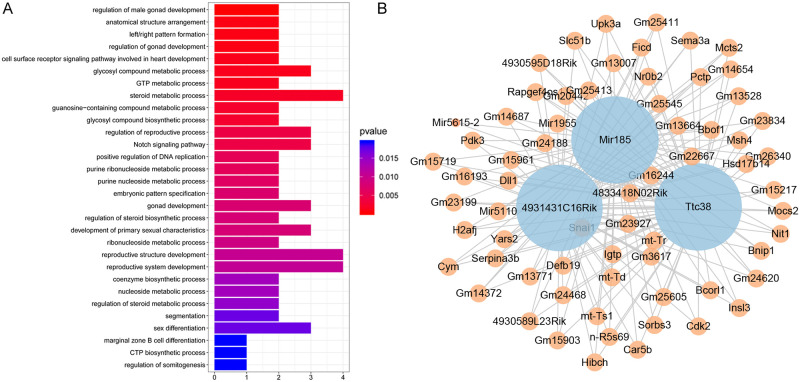
Functional enrichment analysis and the protein-protein interaction (PPI) network of eigengenes in the brown4 module.(A) The GO biological processes that involve the eigengenes in the brown4 module. (B) The PPI network of eigengenes in the brown4 module. The node size indicates the interaction degree.